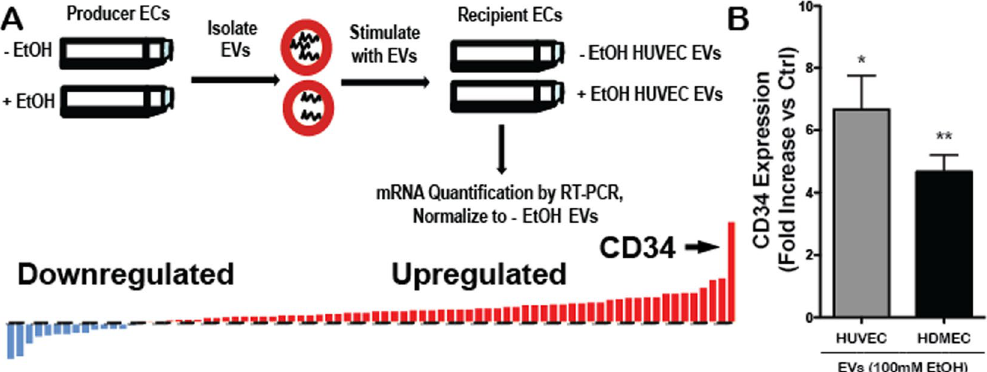
Figure 3. CD34 is upregulated in endothelial cells (ECs) stimulated by EVs from ethanol (EtOH)-conditioned ECs. ( A ) Experimental schematic and representation of gene regulation profile of 92 genes associated with angiogenesis. Data shown represent mRNA levels in recipient HUVECs stimulated by 100 µ g/ml EVs from producer HUVECs cultured in the presence vs. the absence of 100 mM EtOH for 24 h. ( B ) CD34 expression in recipient HUVECs and HDMECs following stimulation by 100 µ g/ml EVs from producer ECs of the same type cultured in the presence or absence (control (Ctrl)) of 100 mM EtOH for 24 h was assessed by qPCR using distinct primers from those in the mRNA array (n = 3; * P < 0.05, ** P <